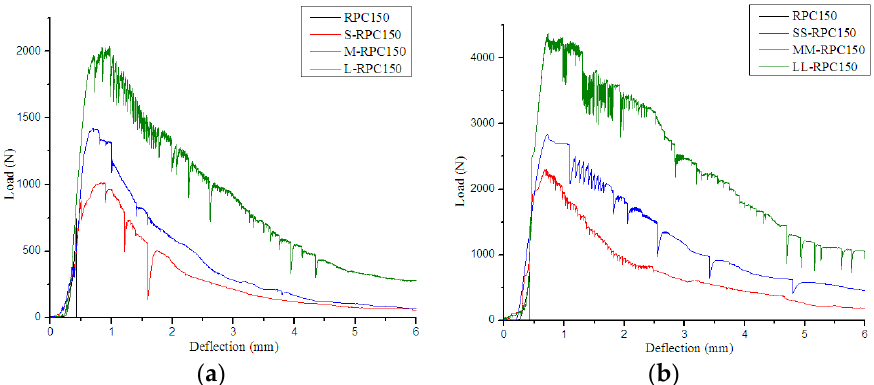
Figure 3. Flexural load–deflection curves for RPC150: ( a ) 0.5% fiber content and ( b ) 2.0% fiber content.